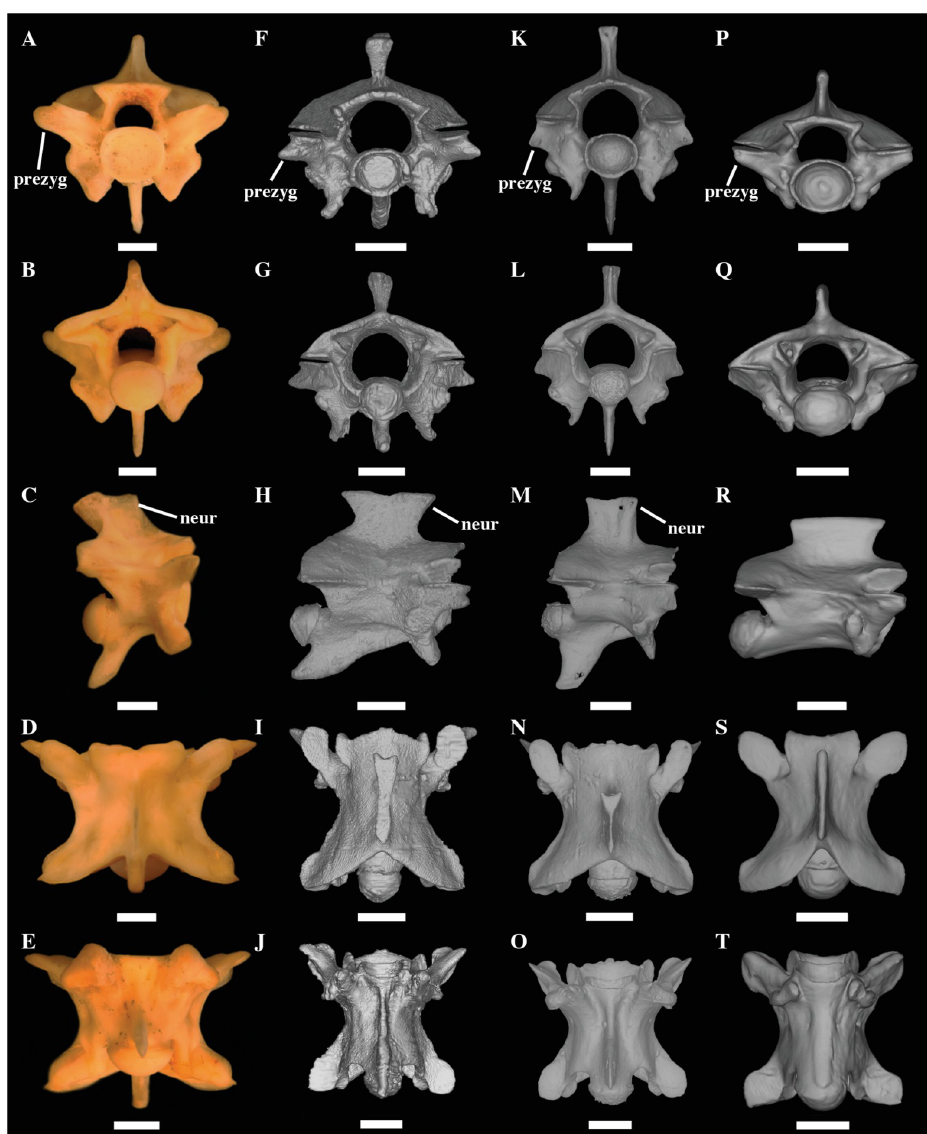
Fig 25. Mid- to posterior trunk vertebrae of Acrochordus javanicus (A-E), Achalinus rufescens (F-J), Fimbrios klossi (K-O), and Pareas sp. (P-T). Photographs (A-E) and three-dimensional surface views based on high resolution X-ray computed tomography. A, F, K, P, anterior views; B, G, L, Q, posterior views; C, H, M, R, right lateral views; D, I, N, S, dorsal views; E, J, O, T, ventral views. Legends: prezyg., prezygapophysial process; neur., neural spine. Scale bar = 2 mm (A-E) and 1 mm (F-T).